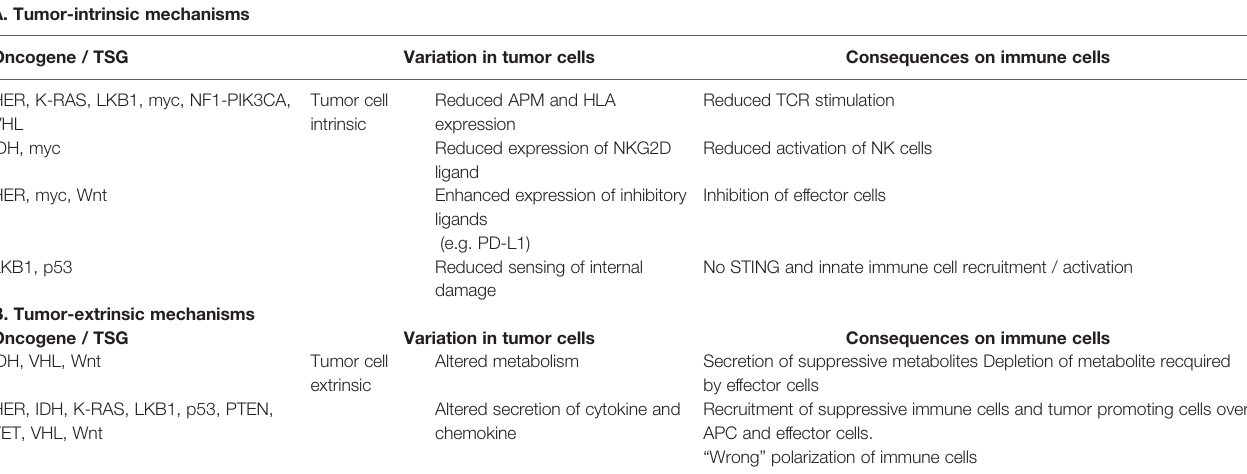
TABLE 1 | Summary of the tumor cell intrinsic and extrinsic immune escape mechanisms mediated by oncogenes and